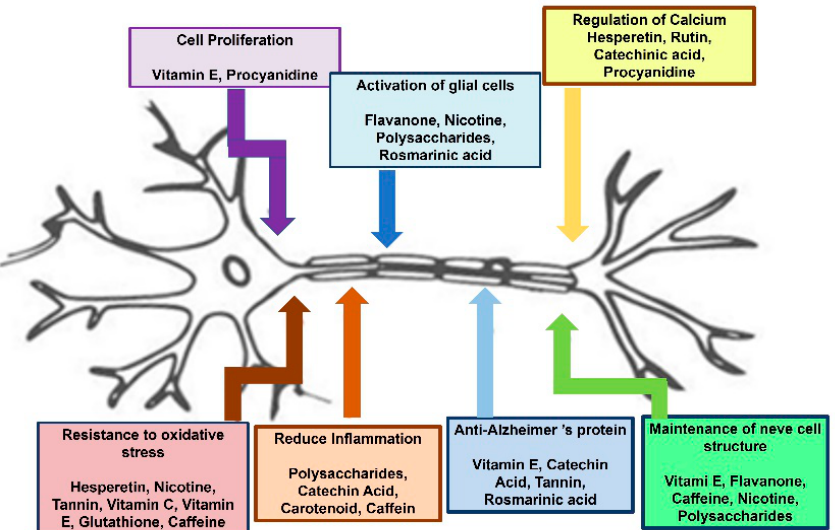
Figure 5. Protective method of plant-derived active substances on nerves. Active plant substances exhibit rich neuroprotective methods, which can be grouped into seven categories: promote the activation of glial cells, promote cell proliferation, regulation of Ca 2+ , maintain nerve cell structure, provide resistance to oxidative stress, reduce inflammation, and anti-Alzheimer’s protein. The active substances falling into each of these seven categories are provided in the respective boxes. All the active substances could resist oxidative stress, and some substances have similar protection patterns.